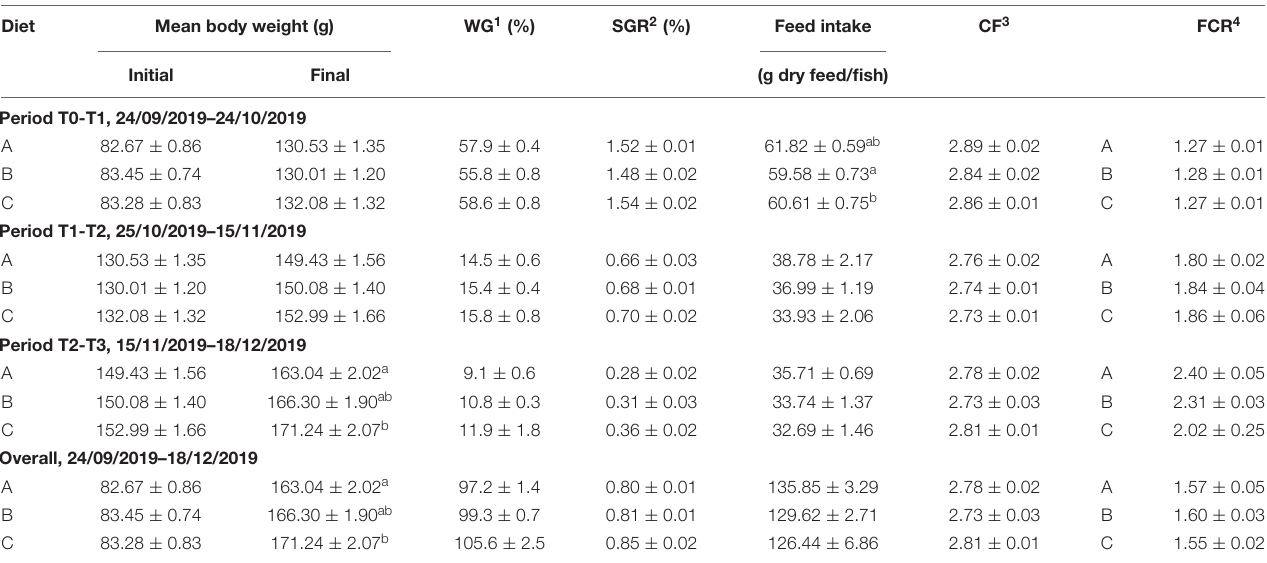
TABLE 3 | Growth performance of gilthead sea bream ( Sparus aurata